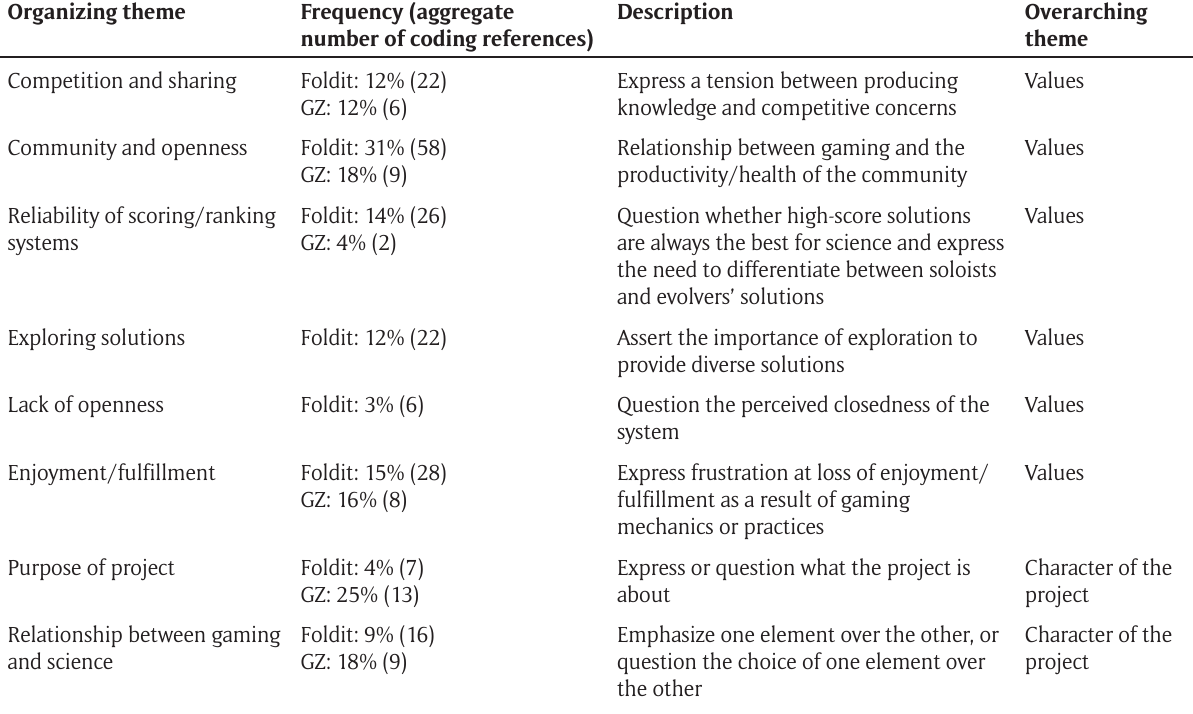
Table 3: Frequency of organizing